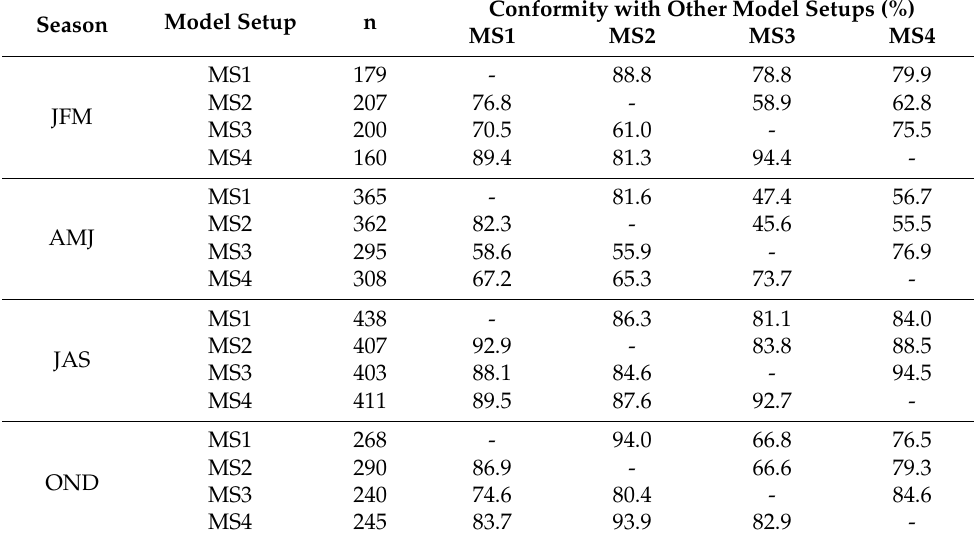
Table 2. Percentage agreement (%) between the four SoilClim model setups in delimitating 10th- percentile soil drought episodes for JFM, AMJ, JAS, and OND in the Czech Republic in the 1961–2020 period; n—number of